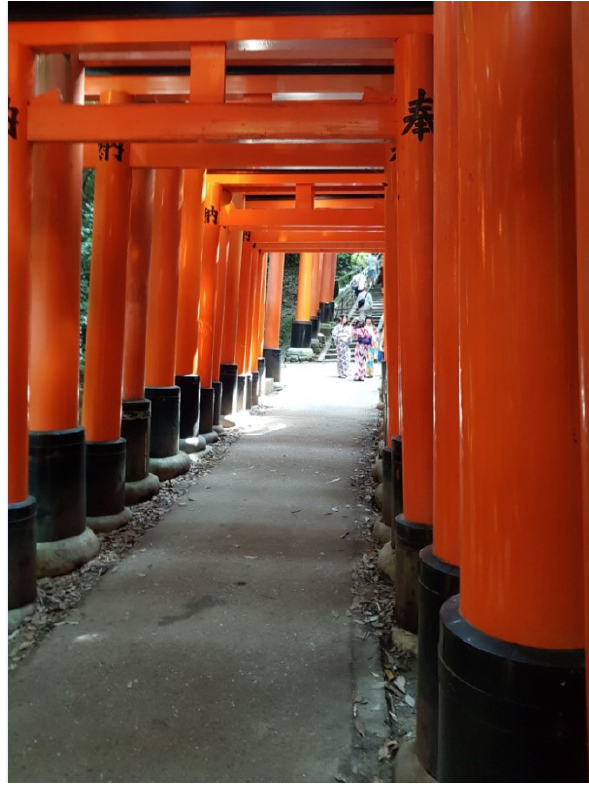
Figure 13: The footpath made by concrete blocks and stones